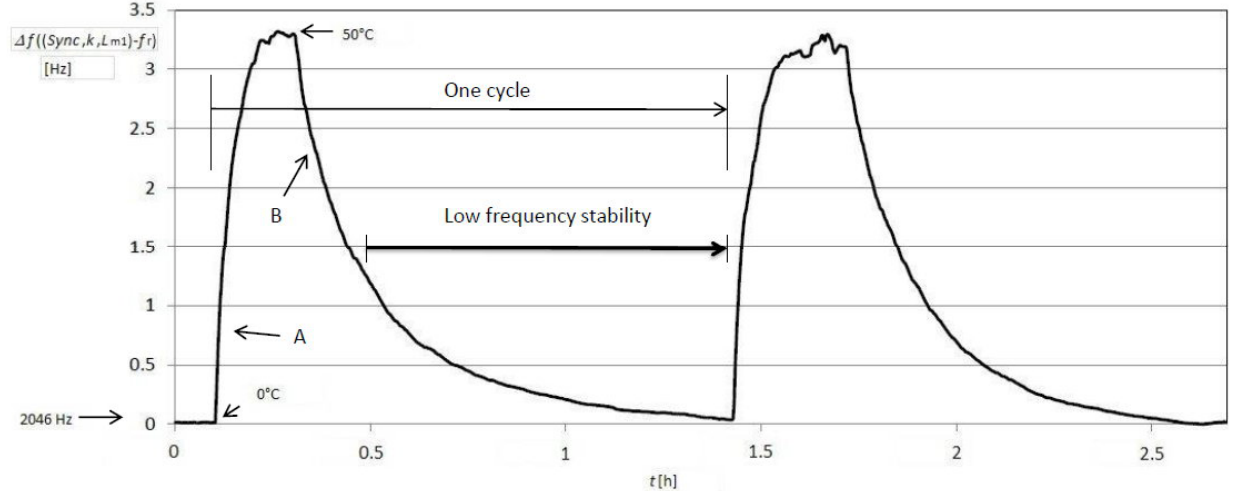
Figure 5. Frequency stability (cid:4666)(cid:1858)(cid:4666)(cid:1845)(cid:1877)(cid:1866)(cid:1855), (cid:1863), (cid:1838) temperature in the range 0–50 °C (measurement time 2.5 h—two